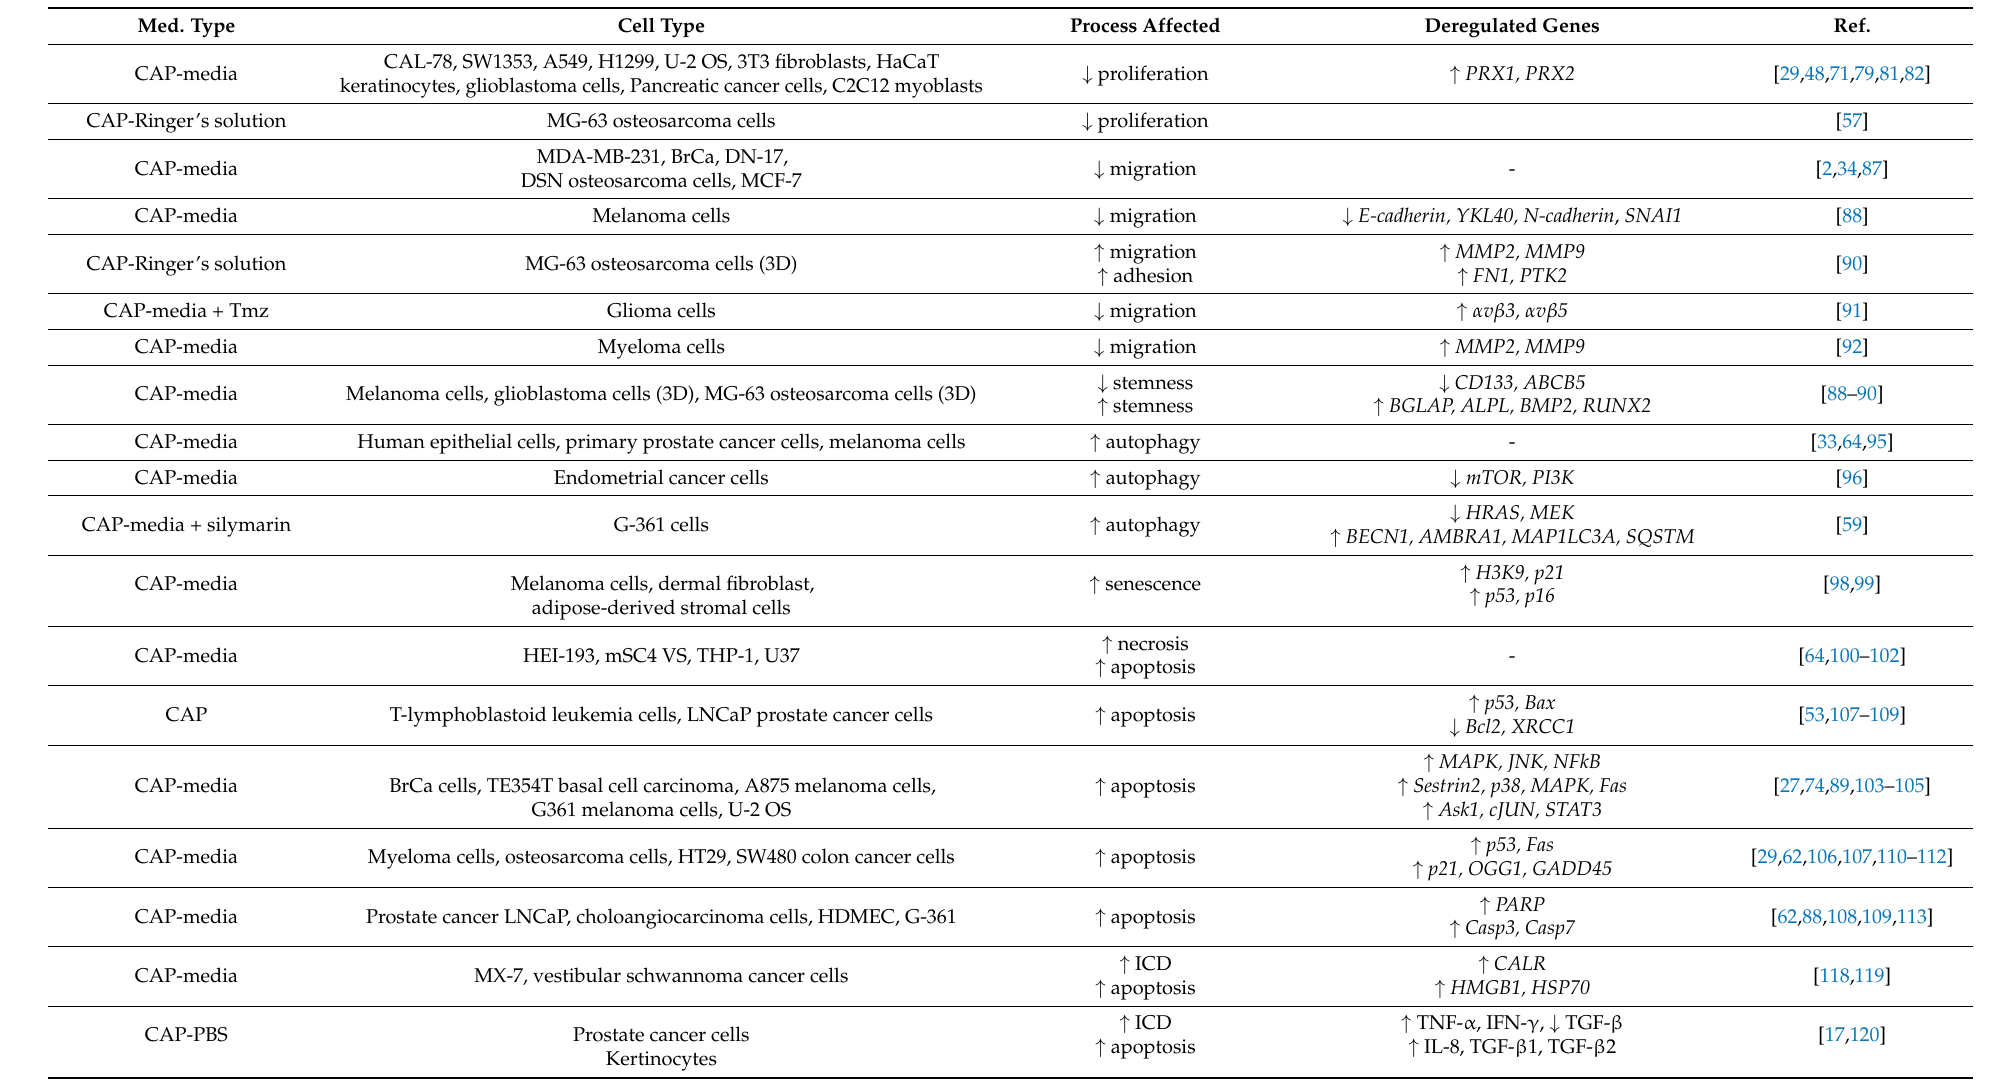
Table 1. Summary of cellular processes and genes either upregulated ( ↑ ) or downregulated ( ↓ ) in different cells exposed to CAP and CAP-activated liquids. Med.